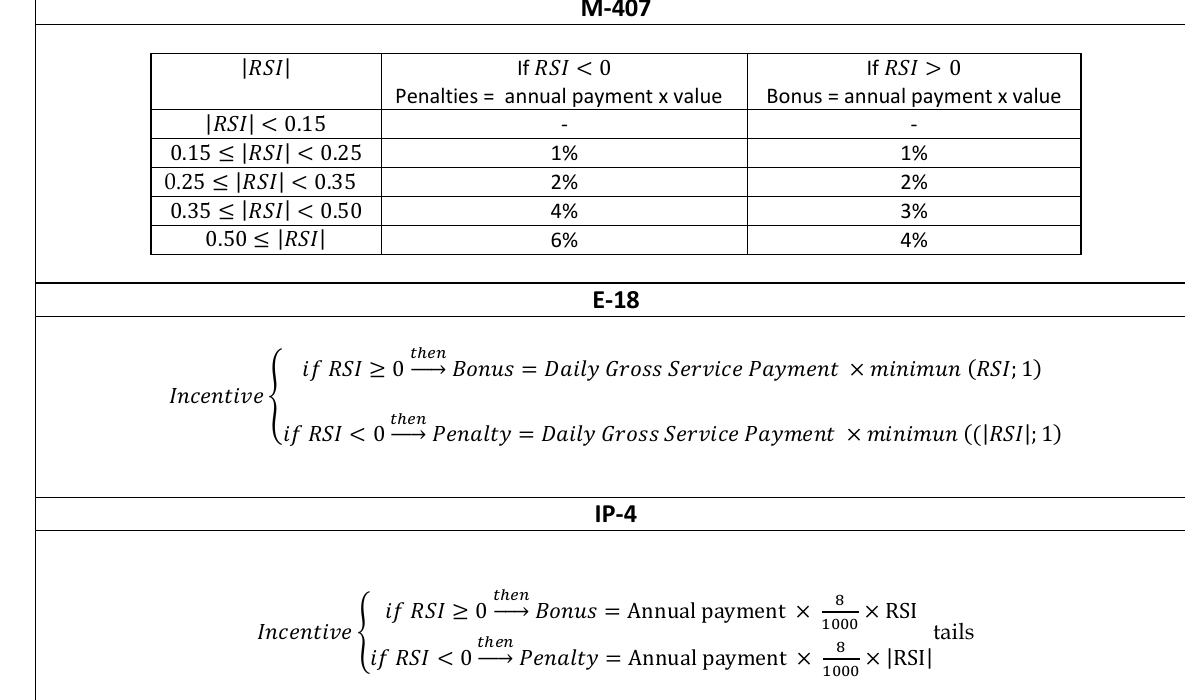
Figure 4. Formulation of road safety incentives included in the selected